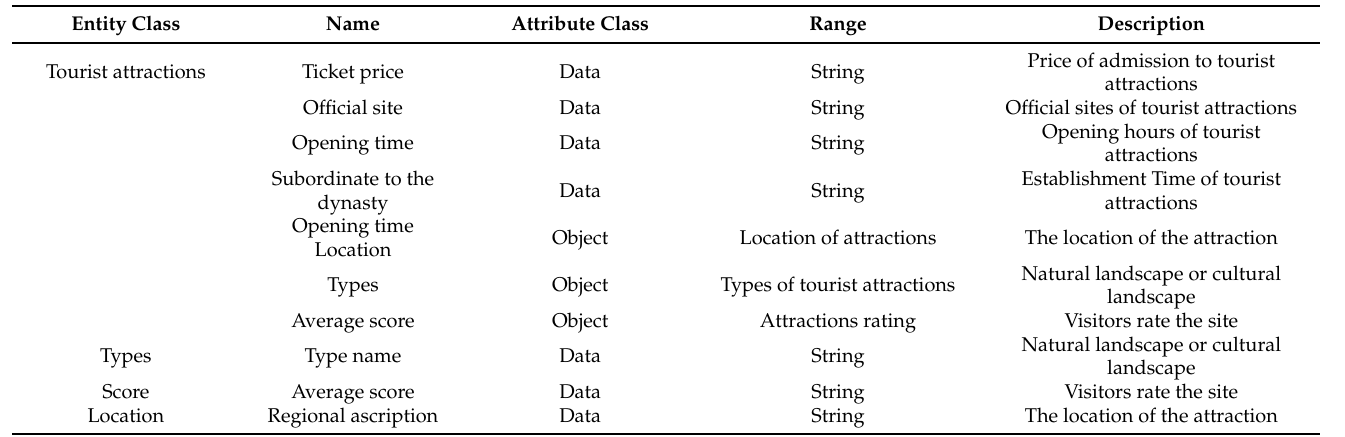
Figure 1. Examples of classification of tourist attractions types. Table 2. Entity attributes of tourist attractions’